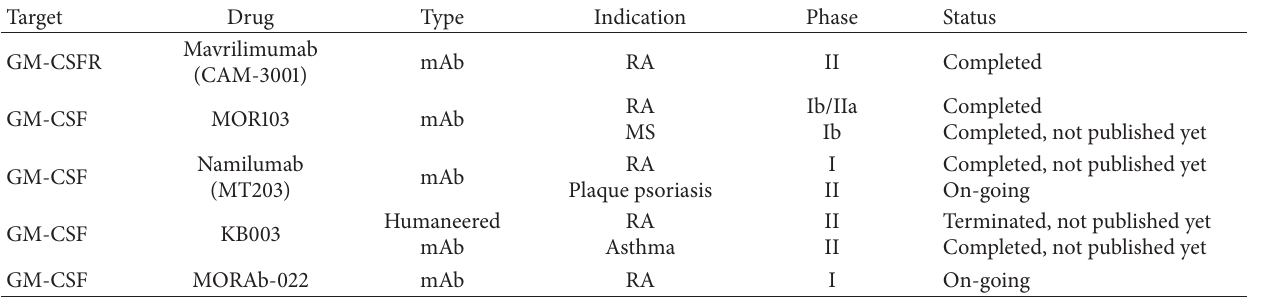
Table 1: Clinical trials targeting GM-CSF.